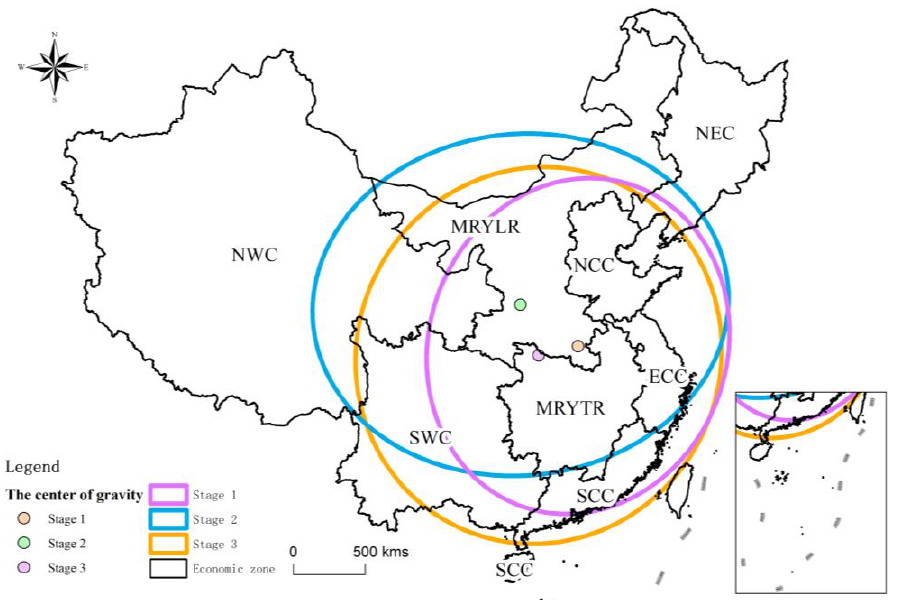
Figure 6. Standard deviation ellipses of urban growth and shrinkage in China from 2012 to 2020. Table 3. Parameters of SDEs.